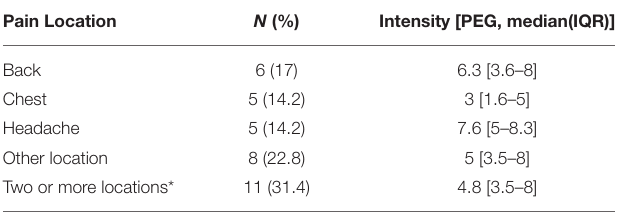
TABLE 2 | Demographics and assessments. TABLE 3 | Pain location in 35 of the 58 subjects.